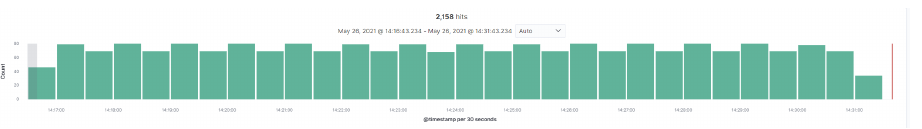
Figure 12. User’s interactions with CYRA.